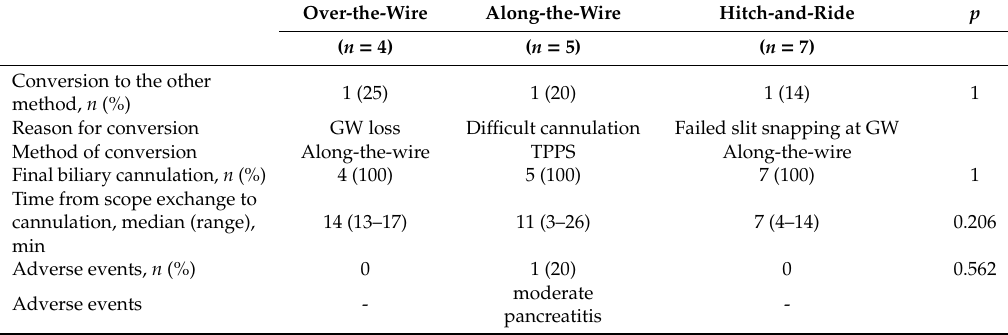
Table 5. Comparison of cannulation methods. Over-the-Wire